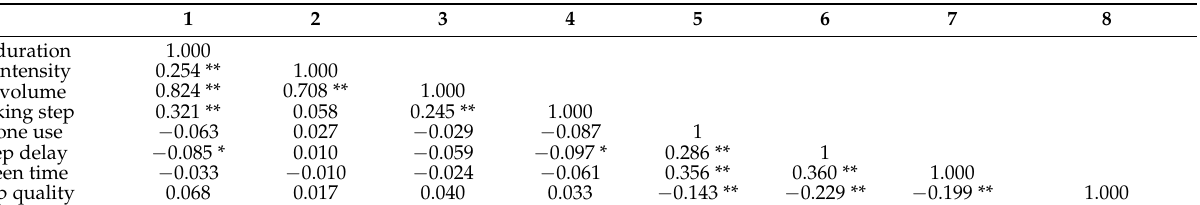
Table 2. Association between core